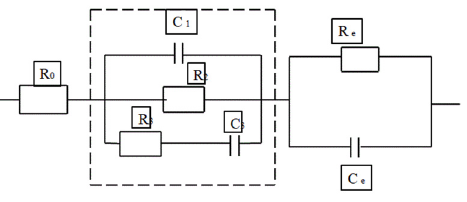
Figure 15. The circuit model for the analysis of the effect of the conductive medium in the composite.